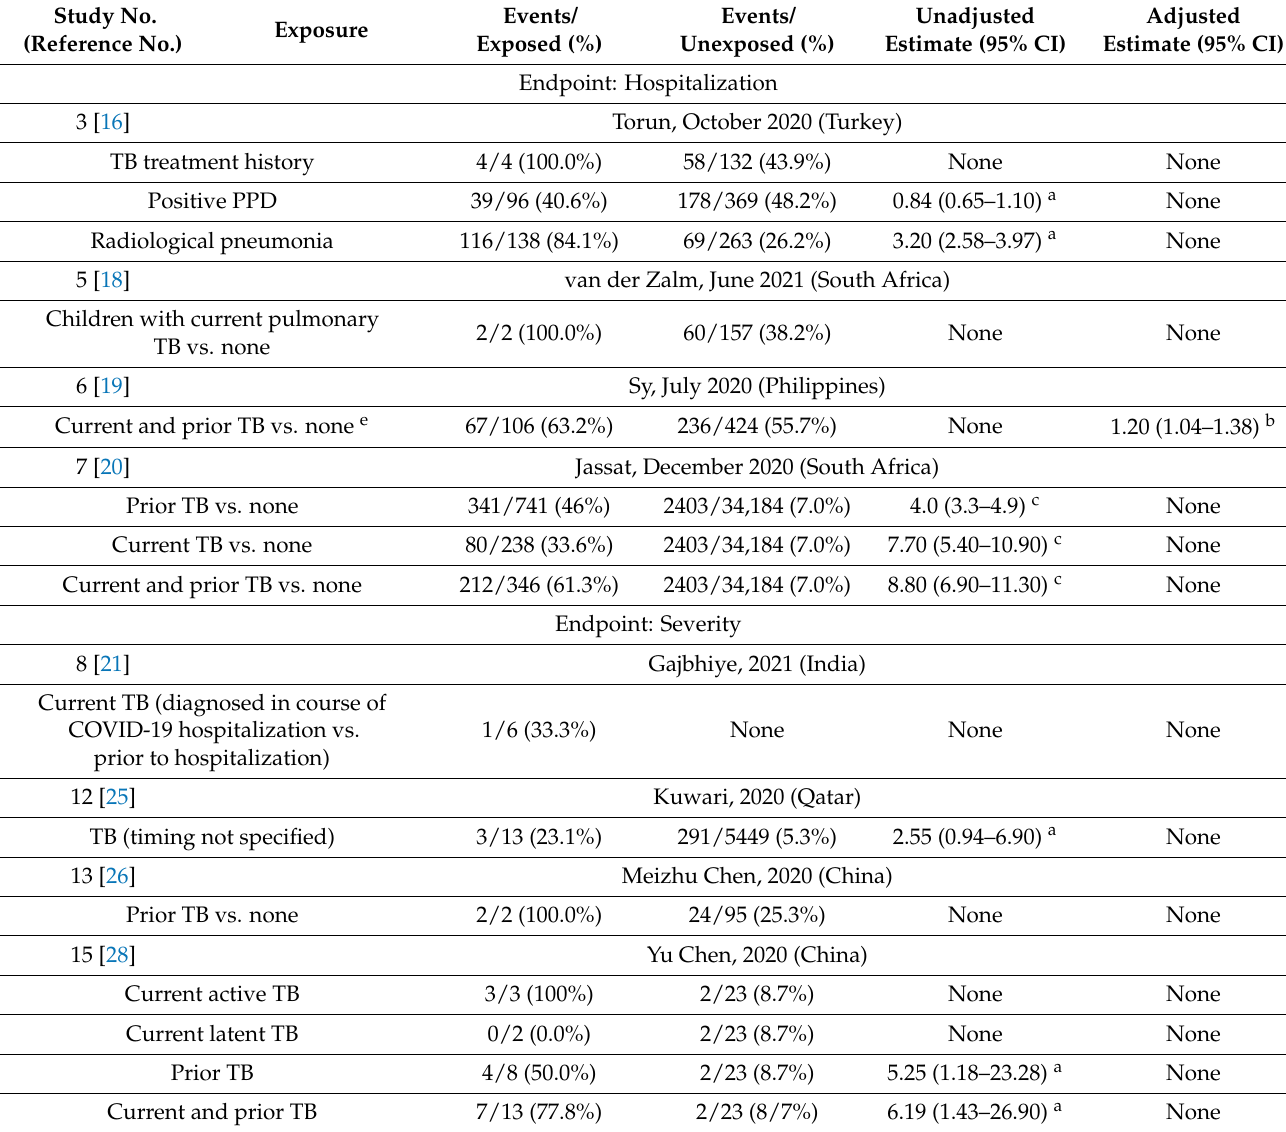
Table 3. Effect estimates for the association between TB and other adverse outcomes related to COVID-19, by endpoint and